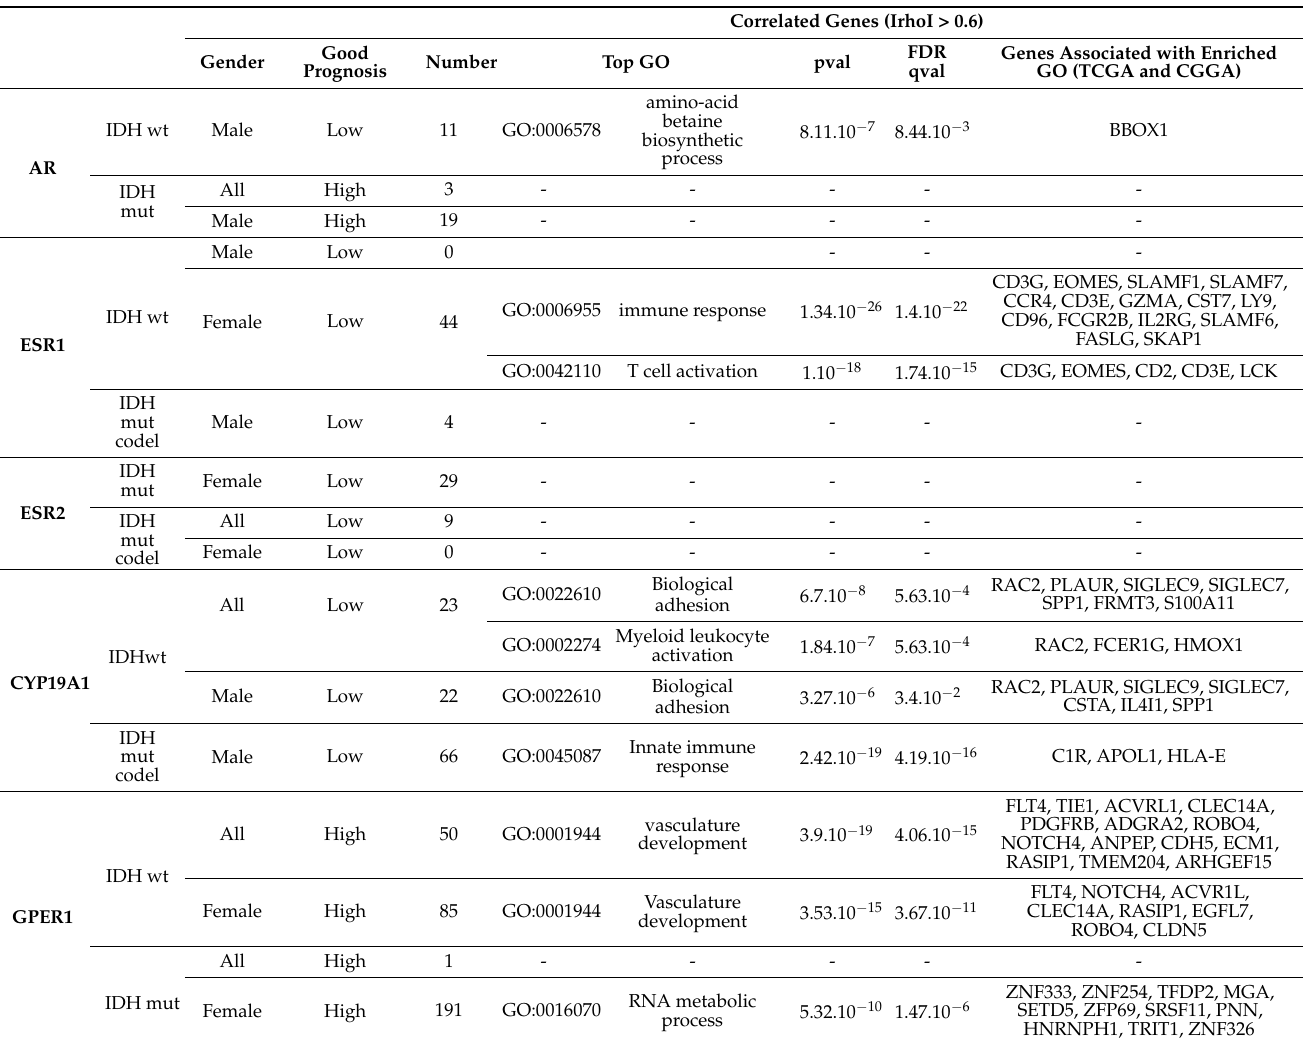
Table 1. Type-specific correlation between key steroid biosynthesis enzyme or hormone receptor expression and patient survival. For each type (IDHwt, IDHmut, IDHmut codel) the correlation between the expression of AR , ESR 1, ESR 2, CYP 19 A 1, or GPER 1 with survival was assessed. The expression level (low or high) corresponding to good prognosis was indicated. GO enrichment analysis of the genes correlated with AR , ESR 1, ESR 2, CYP 19 A 1, or GPER 1 was performed: number of correlated genes, top significant GO terms, enrichment pvalue, and FDRqvalue as well as genes associated with enrichment GO terms, as identified from both TCGA and CGGA databases (based on absolute rho value), were indicated. Correlated Genes (IrhoI > 0.6)